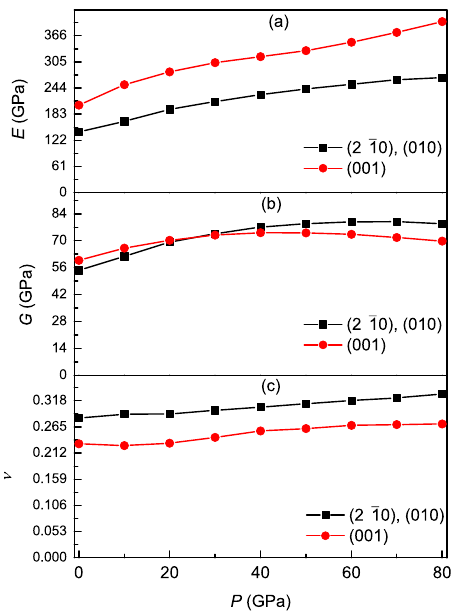
Figure 8. Young’s modulus ( a ), shear modulus ( b ), and Poisson’s ratio ( c ) on the ( 210 ) , (010), and (001) planes as a function of pressure for Ti 3